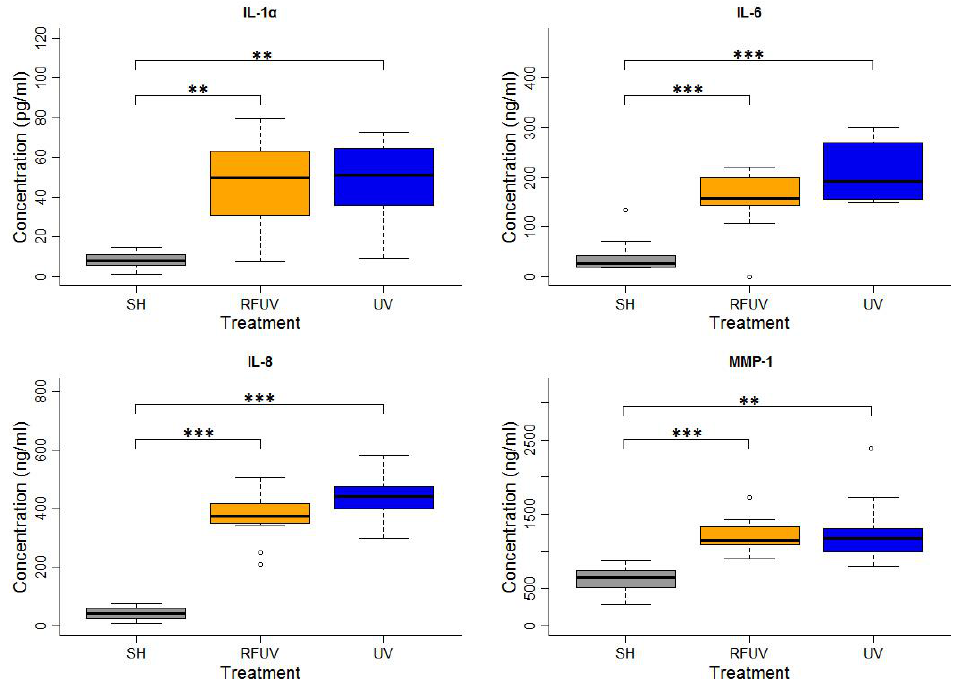
Figure 2. Results of the experiments performed under the adaptive response protocol where pre- exposure of tissues with 2422 MHz continuous Wi-Fi (1.5 W/kg, 24 h) exposure and subsequently with 4 SED UV radiation was performed. The data represent three independent experiments. The boxplot shows the median (thick line) and the lower and upper quartiles (the bottom and top lines of the box), and the whiskers show the minimum and maximum values; ** p < 0.005, *** p < 0.001, ◦ : outlier.